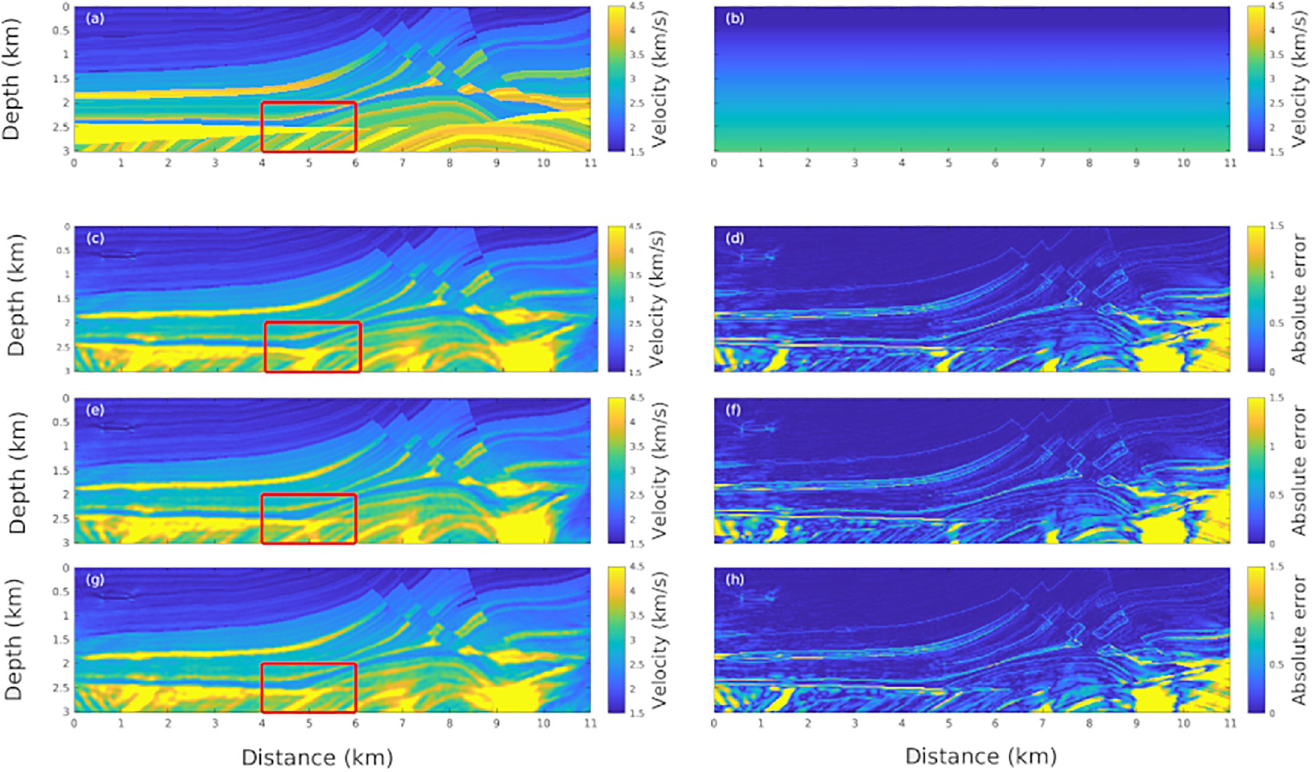
Fig 2. The Marmousi image for different acquisition methods. Panel (a) shows the original Marmousi model. Panel (b) shows the initial input model used in the FWI reconstruction. Panel (c) depicts the Marmousi image constructed using the conventional acquisition procedure while (d) shows the absolute reconstruction error. The reconstruction models using the alternate high/low frequency sensors are shown in panels (e) and (g) for 4x4 and 10x10 arrays; the corresponding absolute errors are shown in (f) and (h).